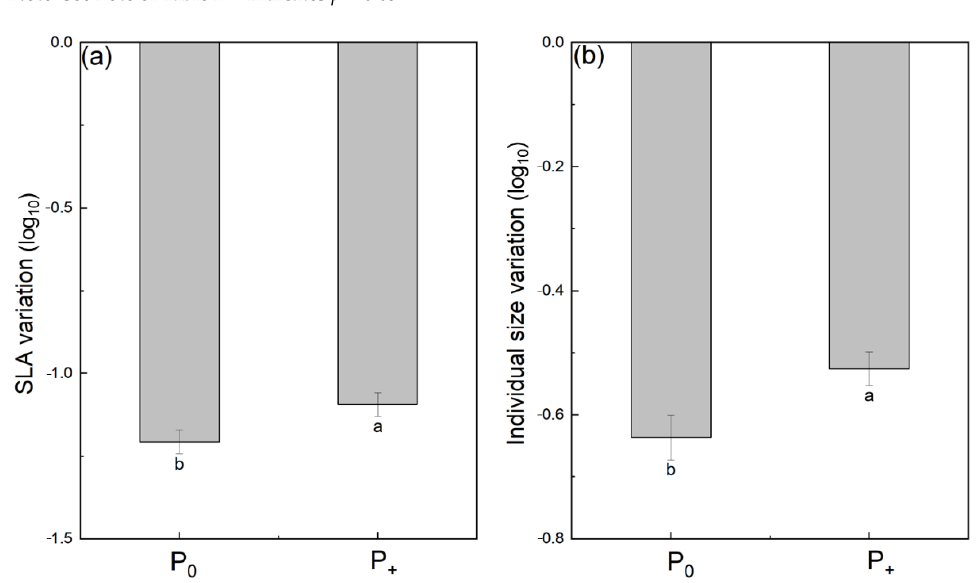
Figure 4. Intraspecific variation of SLA ( a ) and individual size ( b ) of Potentilla anserina under phosphorus addition. P 0 : control treatment; P + : phosphorus addition. Different lower-case letters in the figure indicate the significant difference of the mean value of traits under different treatments, and the paired t -test was used to test the significance.